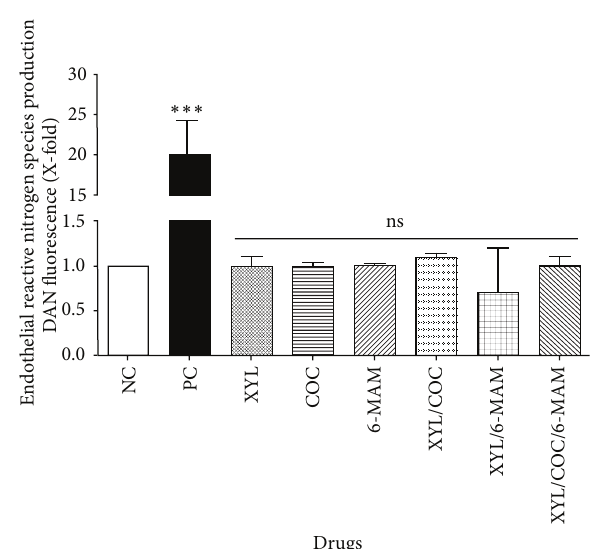
Figure 2: Effect of xylazine, cocaine, 6-MAM, and their combina- tion on RNS production in human umbilical vein endothelial cells (EA.hy926). DAN assay was performed as described previously in the methods section [33, 34]. RNS production after 24 h of expo- sure to vehicle (negative control), xylazine (XYL, 60 𝜇 M), cocaine (COC, 160 𝜇 M), 6-monoacetylmorphine (6-MAM, 160 𝜇 M), camp- tothecin (positive control, 50 𝜇 M), XYL/COC (50 𝜇 M), XYL/6- MAM (50 𝜇 M), and XYL/COC/6-MAM (40 𝜇 M) was determined. Cells exposed to XYL, COC, 6-MAM, and their combinations exhibited no induction of reactive nitrogen species (RNS) in EA.hy926 cells when compared to the negative control; catalytic activity coincides with basal level production of nitrite and nitrate species. Experiments were repeated for at least three times in replicates. All values are expressed as mean ± SD of 6–9 replicates, from 2 to 3 experiments. Statistical analysis performed was one- way ANOVA, with Tukey post hoc test, where 𝑃 < 0.05 was considered to be significant. 𝑃 summary; ∗∗∗ significantly different from negative control group ( 𝑃 < 0.0001 ), ns = no significant difference from negative control group ( 𝑃 > 0.05 ). Results percent (%) was calculated by negative control